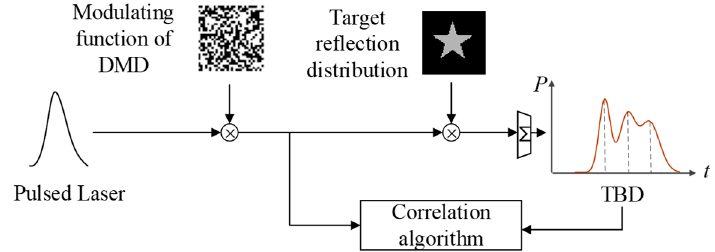
Figure 4. Step I: Depth information of targets is extracted based on finite difference.